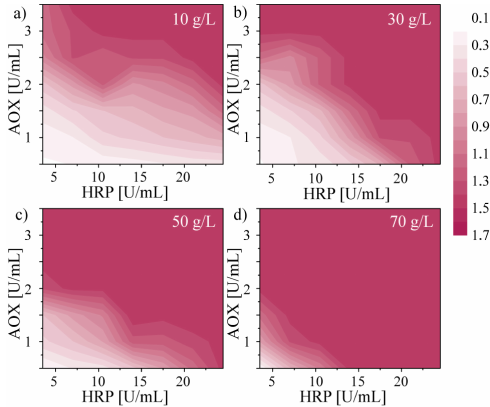
Figure 3. Maps of measured absorbance of quinoneimine dye at 490 nm with the use of enzymes AOX (0.5 to 3.5 U·mL −1 ) and HRP (3.5 to 24.5 U·mL −1 ) and chromogenes PSA (25 mM) and 4-AAP (0.4 mM) for four concentrations of ethanol (10, 30, 50 and 70 g·L −1 ). Absorbance was measured with the use of the chip DET .